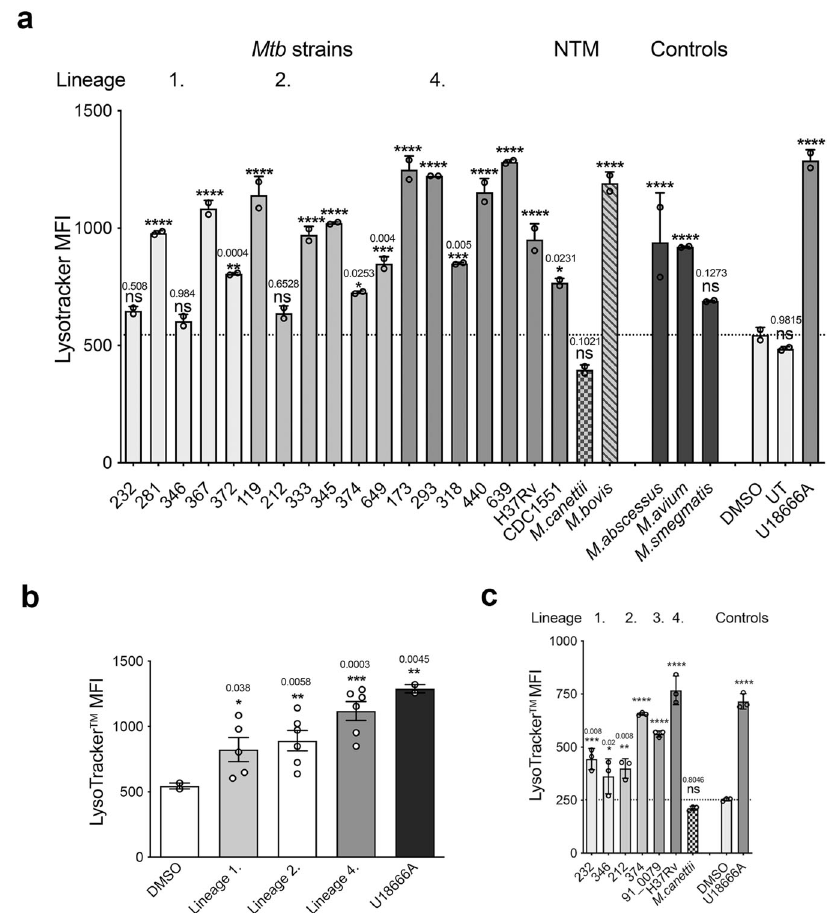
Fig. 1 | Mycobacterial lipids that can signi fi cantly increase LysoTracker ™ staining of RAW 264.7M Φ are widely distributed across Mtb clinical strains, members of the Mtb complex (MTBC) and non-tuberculous mycobacteria. a LysoTracker ™ staining intensity of RAW 264.7M Φ treated with 100 μ g/ml lipid extract of clinical Mtb strains representative of Mtb lineages, 1, 2, and 4, Mtb complex species and non-tuberculous mycobacteria for 48h. Data are mean± SEM, N =minimum of 2 replicates per sample. Statistical analysis, 1-way ANOVA, **** p <0.0001,other signi fi cance values as indicated. Data are representative of three independent experiments. b Mean LysoTracker ™ staining intensity of RAW